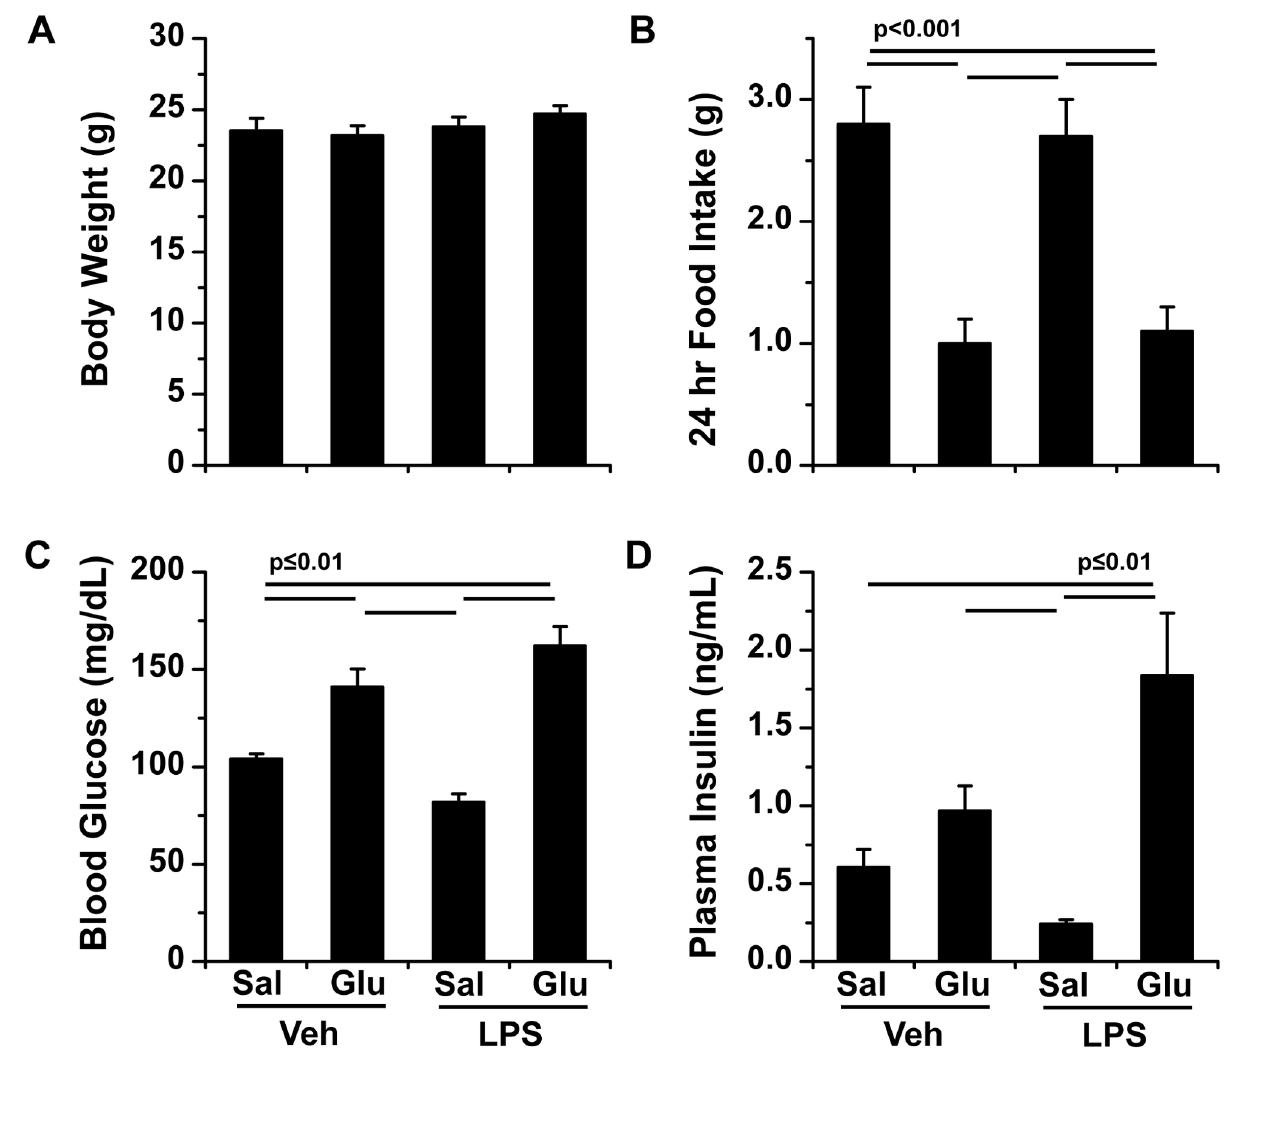
Figure 2. Physiological variables. Mean ± SEM for (A) body weight, (B) food intake over 24 hrs prior to lipopolysaccharide (LPS; 1 mg/kg) administration (note: glucose infused mice consumed fewer calories as the glucose accounted for approximately 40% of their daily calorie intake), (C) pre-FSIVGTT blood glucose, and (D) plasma insulin 5 hrs after either LPS or vehicle (Veh) administration in mice infused with either saline (Sal) or glucose (Glu) at 100 µL/hr for 29 hrs. Statistical differences were determined by two-way ANOVA with differences between individual means determined by post-hoc Bonferroni tests. doi: 10.1371/journal.pone.0067716.g002 The combination of endotoxemia and glucose infusion levels to the Veh Glu group (567±9 [LPS Glu] mg/dL), but induces marked insulin resistance and impairs first glucose disposal was markedly impaired (Figure 4B and Figure phase insulin secretion 5A solid triangles). Thus, whereas we demonstrate a distinct lack of impairment of glucose disposal in response to glucose During saline infusion, the peak insulin secretion was infusion or endotoxin alone, mice exposed to the combination comparable between the Veh Sal (29.8±10.5 ng/ml) and LPS of LPS and Glu experience profound glucose intolerance. Sal (30.2±5.9 ng/ml) groups (Figure 4C, open and closed diamonds). Although the decay curve for insulin appeared slightly slower for the LPS Sal group than the Veh Sal group,